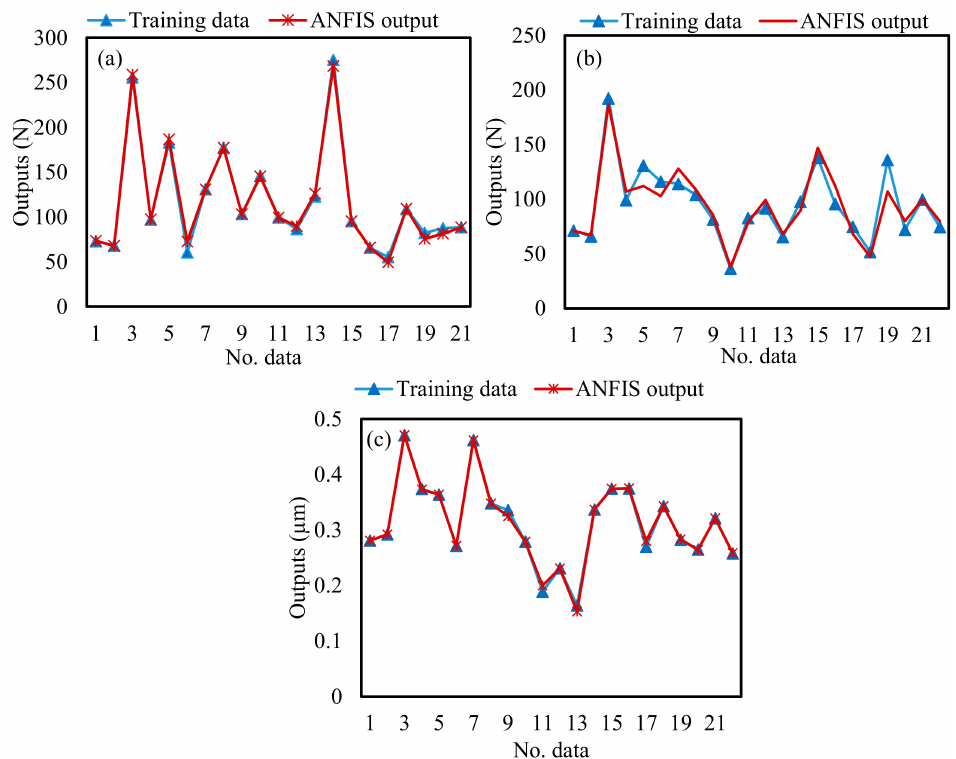
Figure 6. Comparison between the training data and the ANFIS outputs ( a ) depth force; ( b ) feed force; ( c ) surface roughness.